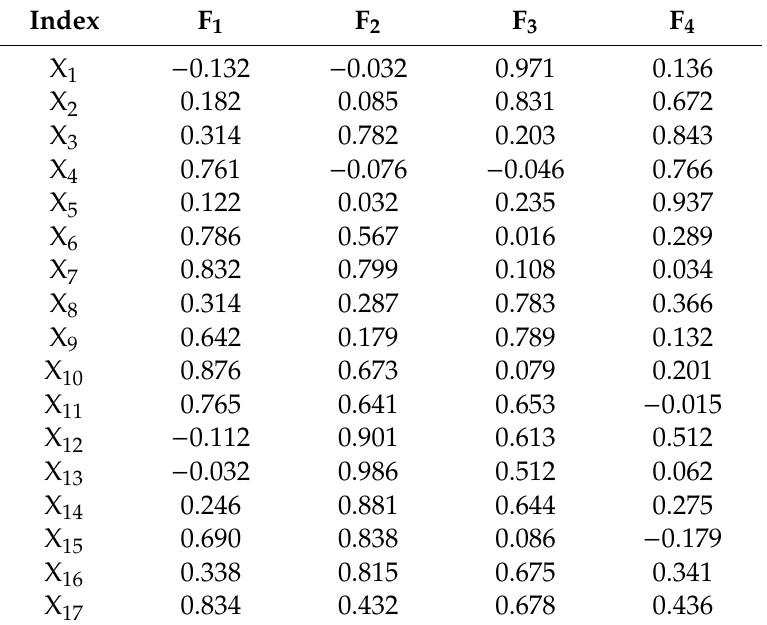
Table 5. Factor loading matrix after rotation.